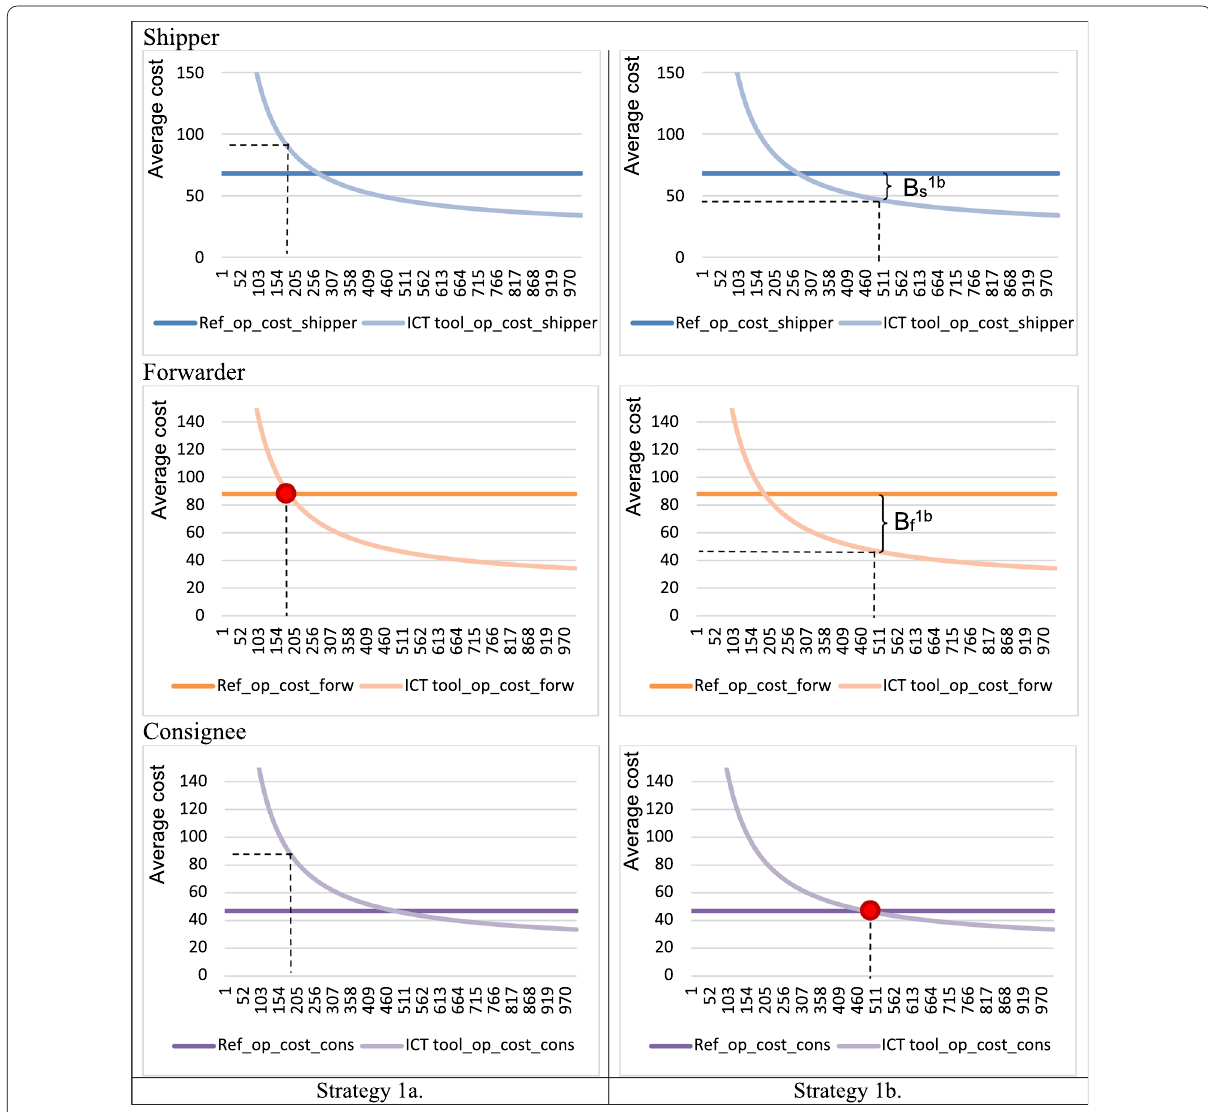
Fig. 5 User average costs if strategy 1 is applied. Source : own